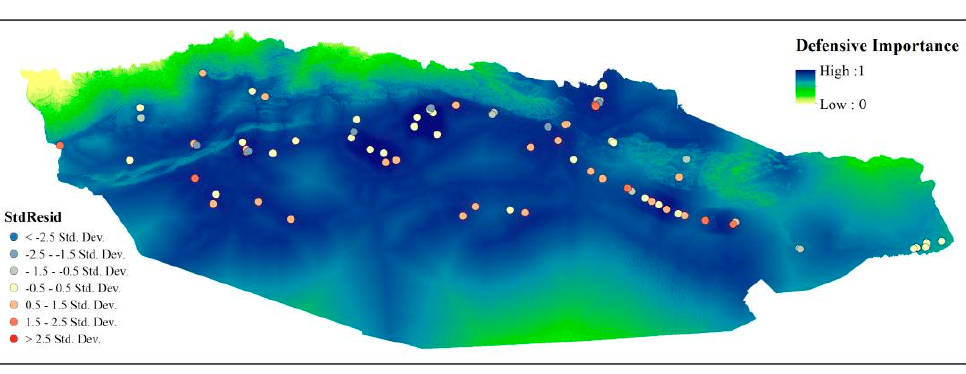
Figure 5. Linear regression of defensive importance in the Han Dynasty.